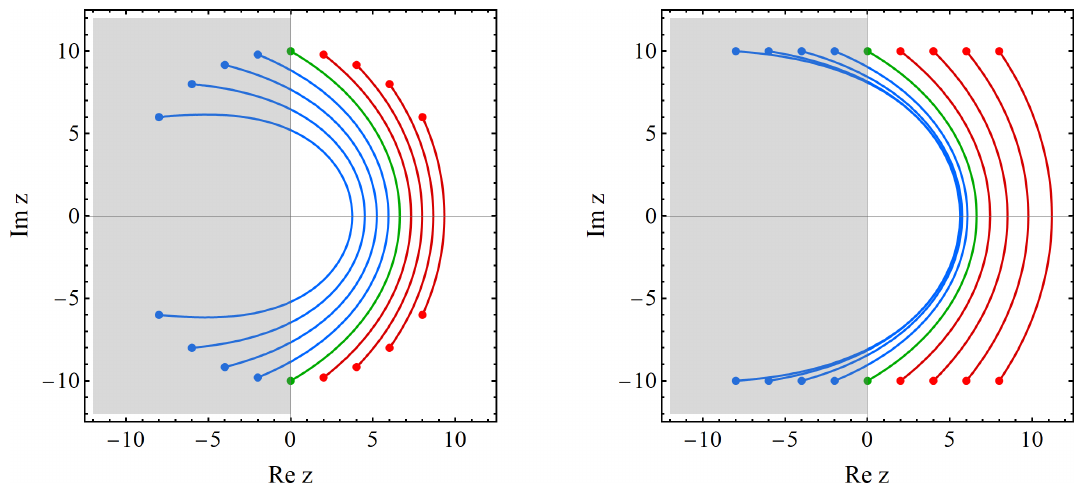
Figure 8 . The Stokes lines for spin-1 bosons (left panel) and spin-1/2 fermions (right panel). In both panels, the chemical potential ranges over ˜ κ = − 8 , − 6 , · · · , 6 , 8 (from left to right, and the green lines correspond to the case without chemical potential), with spin-1 boson mass and spin-1/2 fermion mass µ = ˜ m = 10 . The gray region with Re z < 0 cannot be reached physically in dS.